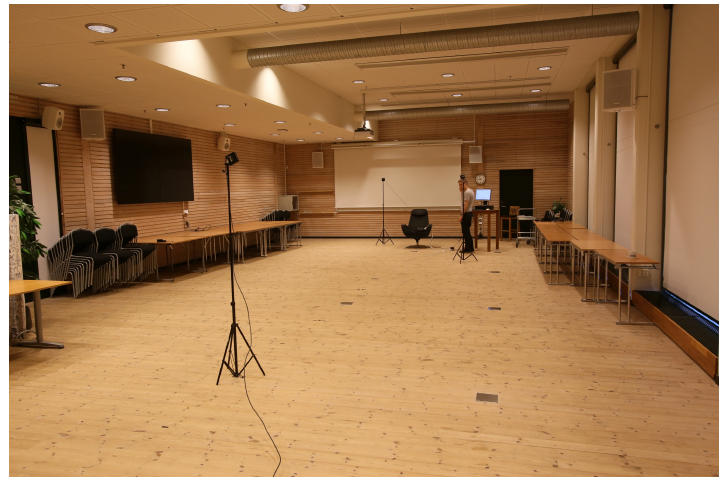
Figure 1. Multi-purpose lecture hall with the transmitter (foreground) which is moved to six different distances away from the receiver (background) during the measurement campaign. Legend